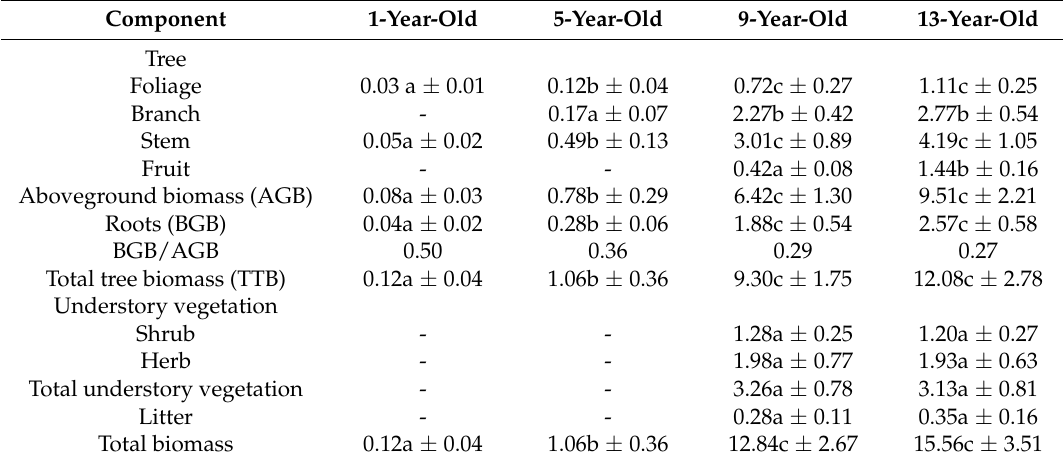
Table 4. Biomass carbon (Mg ha − 1 ) in trees, understory vegetation, and litter in 1-, 5-, 9-, and 13-year-old J. regia plantations ( n = 3).